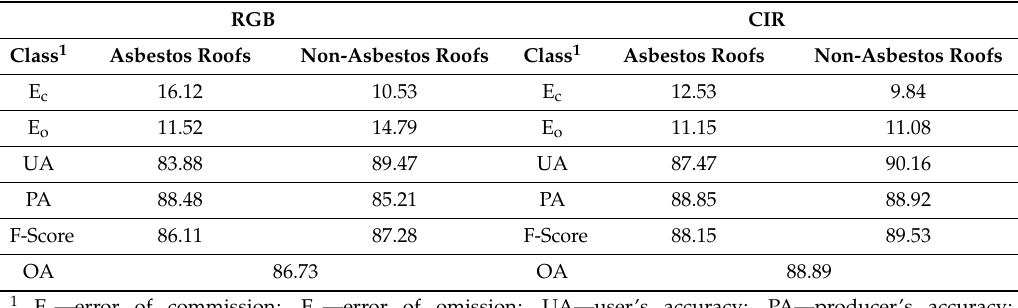
Table 1. Asbestos covered roofs classification accuracy measures for RGB and CIR compositions (reported in %).